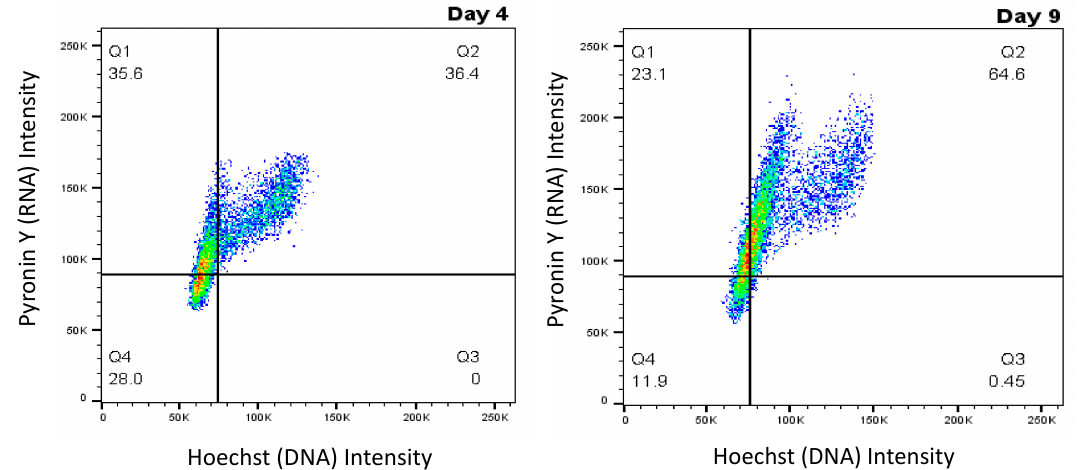
Figure A1. Culture viability profile across different osmolality values. The cultures were harvested on the day after the final measurement reported herein, when the viability in one of the biological duplicates dropped below 80%.